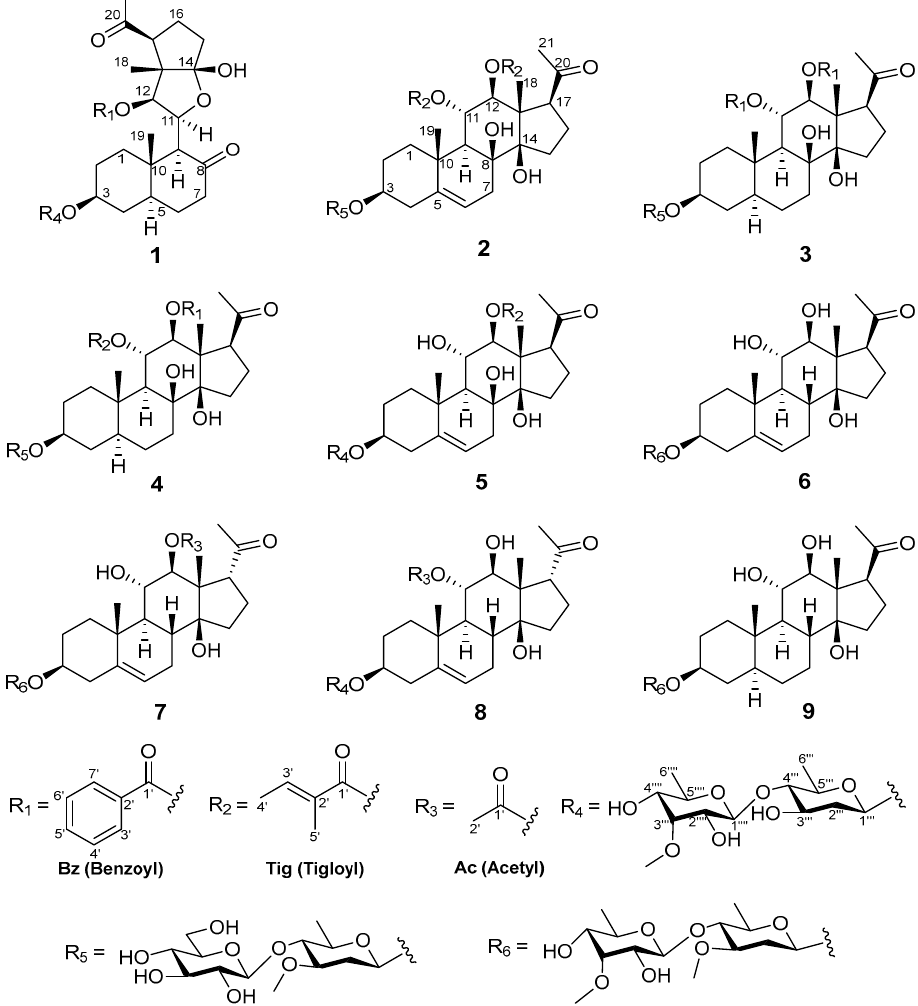
Figure 1. Structures of new compounds 1 ‒ 9 from Marsdenia tenacissima .